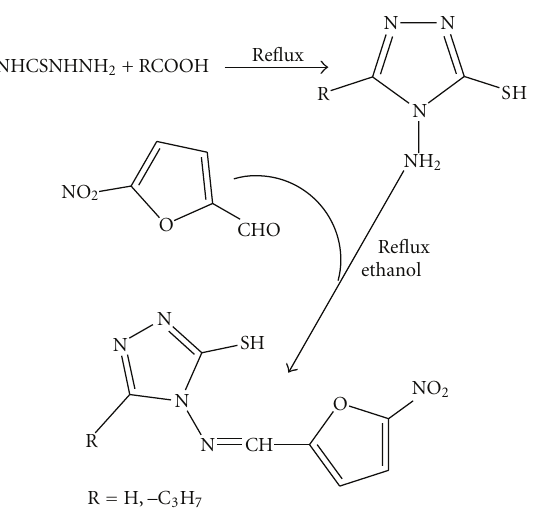
Figure 1: Scheme for the syntheses of Schi ff bases.